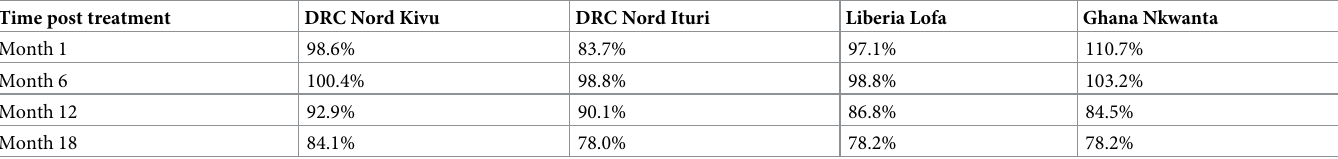
Treatment difference: difference between adjusted geometric means in the ivermectin treatment arm and the moxidectin treatment arm in percentage of the adjusted geometric means in the ivermectin treatment arm obtained from the linear model. Treatment differences > 100% are due to low values of SmfD in the moxidectin arm that are log-transformed to calculate geometric mean differences. For summaries of skin microfilariae density means, geometric means, adjusted means and geometric means and adjusted difference of means and geometric means see Tables S5-S8 in S 1 File